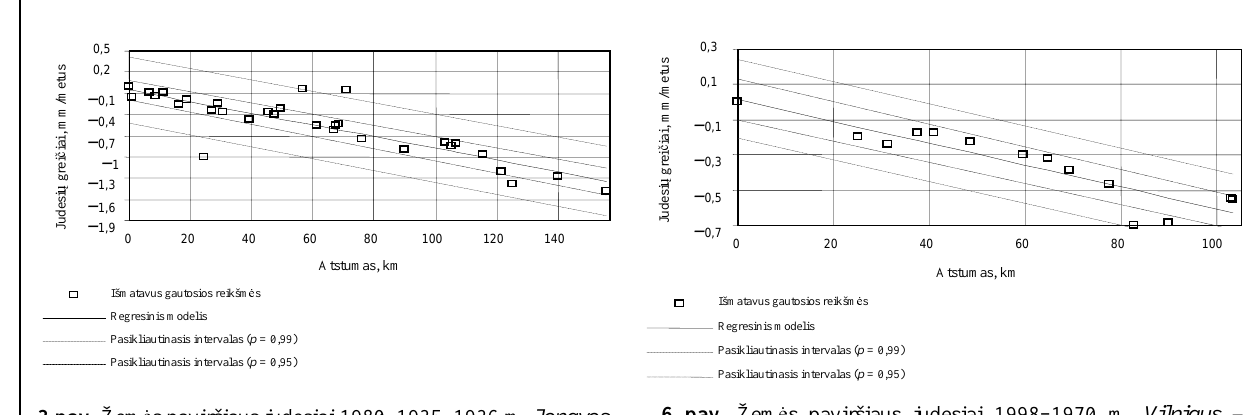
Fig 5. Earth surface movements (1970–1948) in line Vilnius – Jonava (linear model)